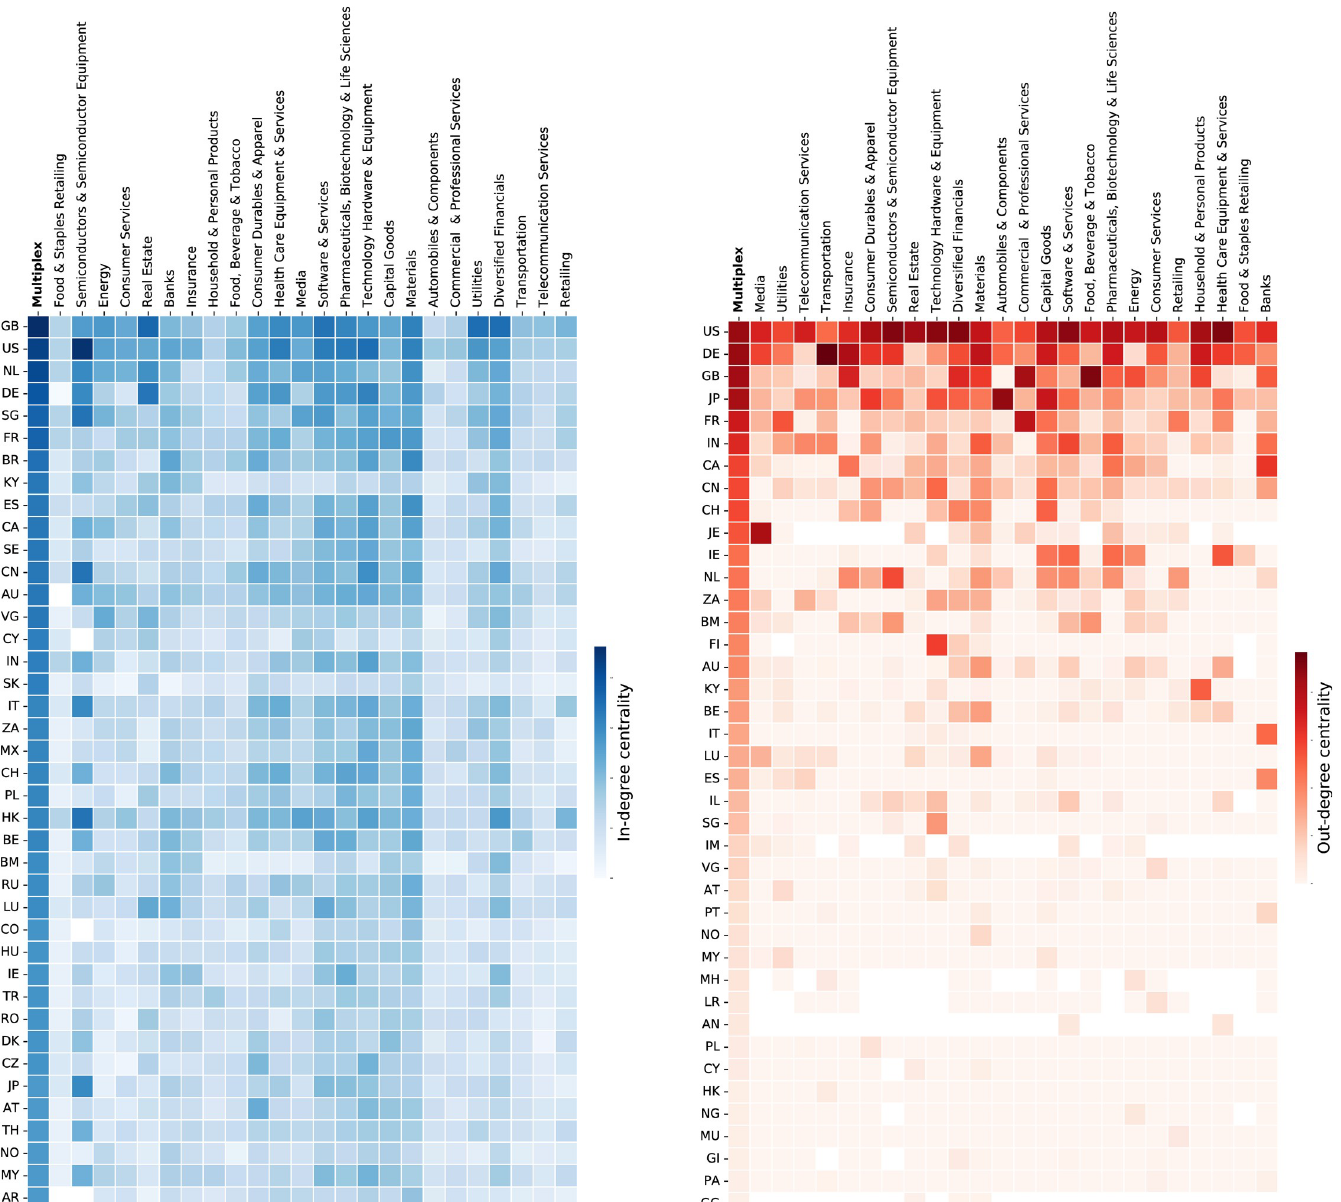
Fig 1. a. In-degree centralities for single-layer and multiplex industry networks. Each column corresponds to a different layer (sector) of the multiplex network, which is shown in the first column. Each row corresponds to a different country, being ordered by decreasing values of in-degree centrality according to the multiplex ranking. The darker the colour, the higher the centrality. Top 40 countries are shown by two-digit ISO-2 code. b. Out-degree centralities for single-layer and multiplex industry networks. Each column corresponds to a different layer (sector) of the multiplex network, which is shown in the first column. Each row corresponds to a different country, being ordered by decreasing values of out-degree centrality according to the multiplex ranking. The darker the colour, the higher the centrality. Top 40 countries are shown by two-digit ISO-2 code. https://doi.org/10.1371/journal.pone.0255450.g001 sectors are organised as sub-networks. Though this often conforms to regions of the world (e.g. Latin American firms connecting through regional subsidiaries), it may also be indica- tive of a fragmented structure as determined by non-spatial proximities [78, 79].